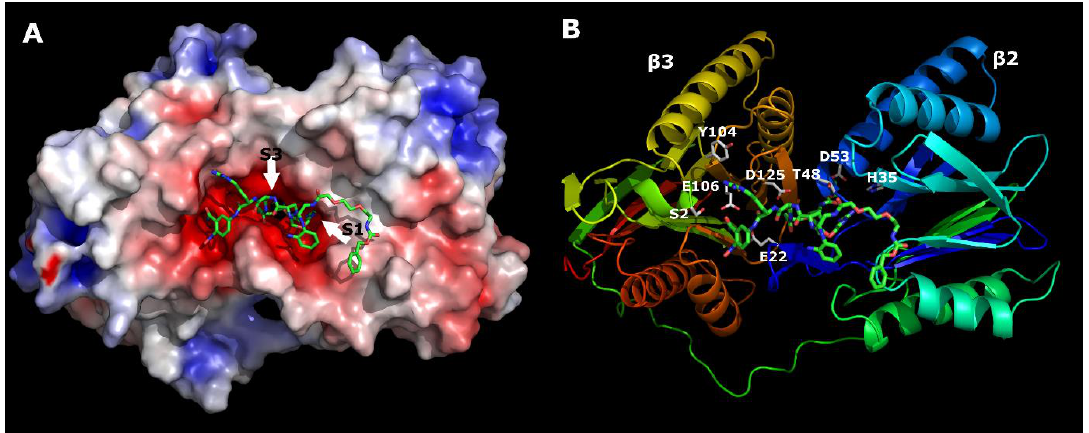
Figure 7. Theoretical model of the ligand ABZ–Dap(O2(Cbz))–Dap(GO1)–Dap(O2(Cbz))–Arg–ANB–NH 2 interacting with β2 and β3 subunits of the 20S proteasome. ( A ) Electrostatic surface (red: negative charge; blue: positive charge), ( B ) the most important residues at the proteasome–ligand interface. Arrows indicate the location of the S1 and S3 binding pockets.